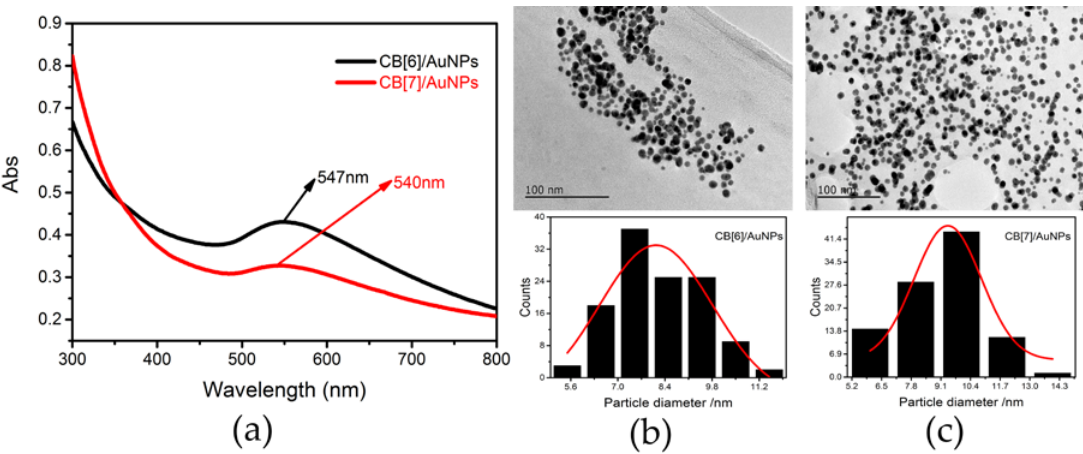
Figure 1. ( a ) UV-vis spectra of the prepared AuNPs. TEM micrographs and their corresponding histograms of ( b ) CB[6]/AuNPs and ( c ) CB[7]/AuNPs.